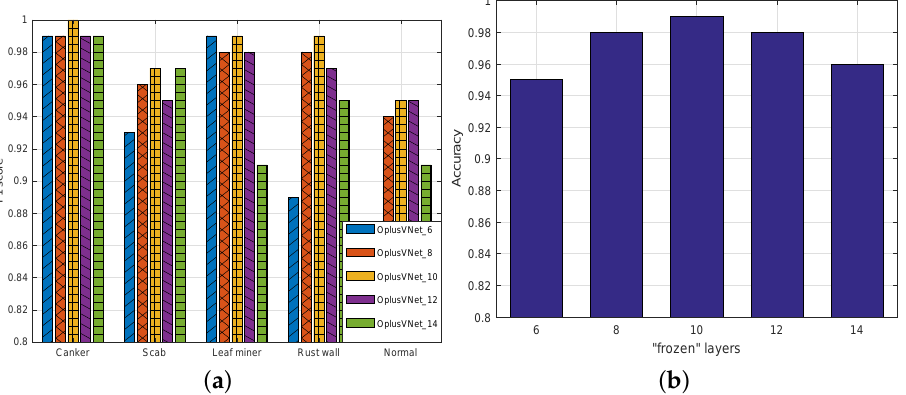
Figure 3. Performance analysis of different transfer learning network models. ( a ) F1 score of different OplusVNet models on various citrus pests and diseases. ( b ) The accuracy of different OplusVNet models on the validation